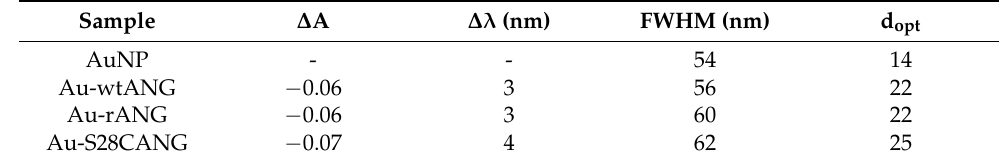
Figure 2. ( a ) UV-visible spectra of ( a ) 8.24 × 10 8 NP/mL AuNPs in 1 mM MOPS (pH = 7.4) before (wine) and after the addition of 5 × 10 −8 M of ANG (red = wtANG; green = rANG; cyan = S28CANG). In the inset a magnification of the plasmon peak is shown. ( b ) UV-visible spectra of the pellets collected after the washing procedure and re-suspended in MOPS buffer (dashed lines) for bare AuNP and hybrids AuNP-ANG.